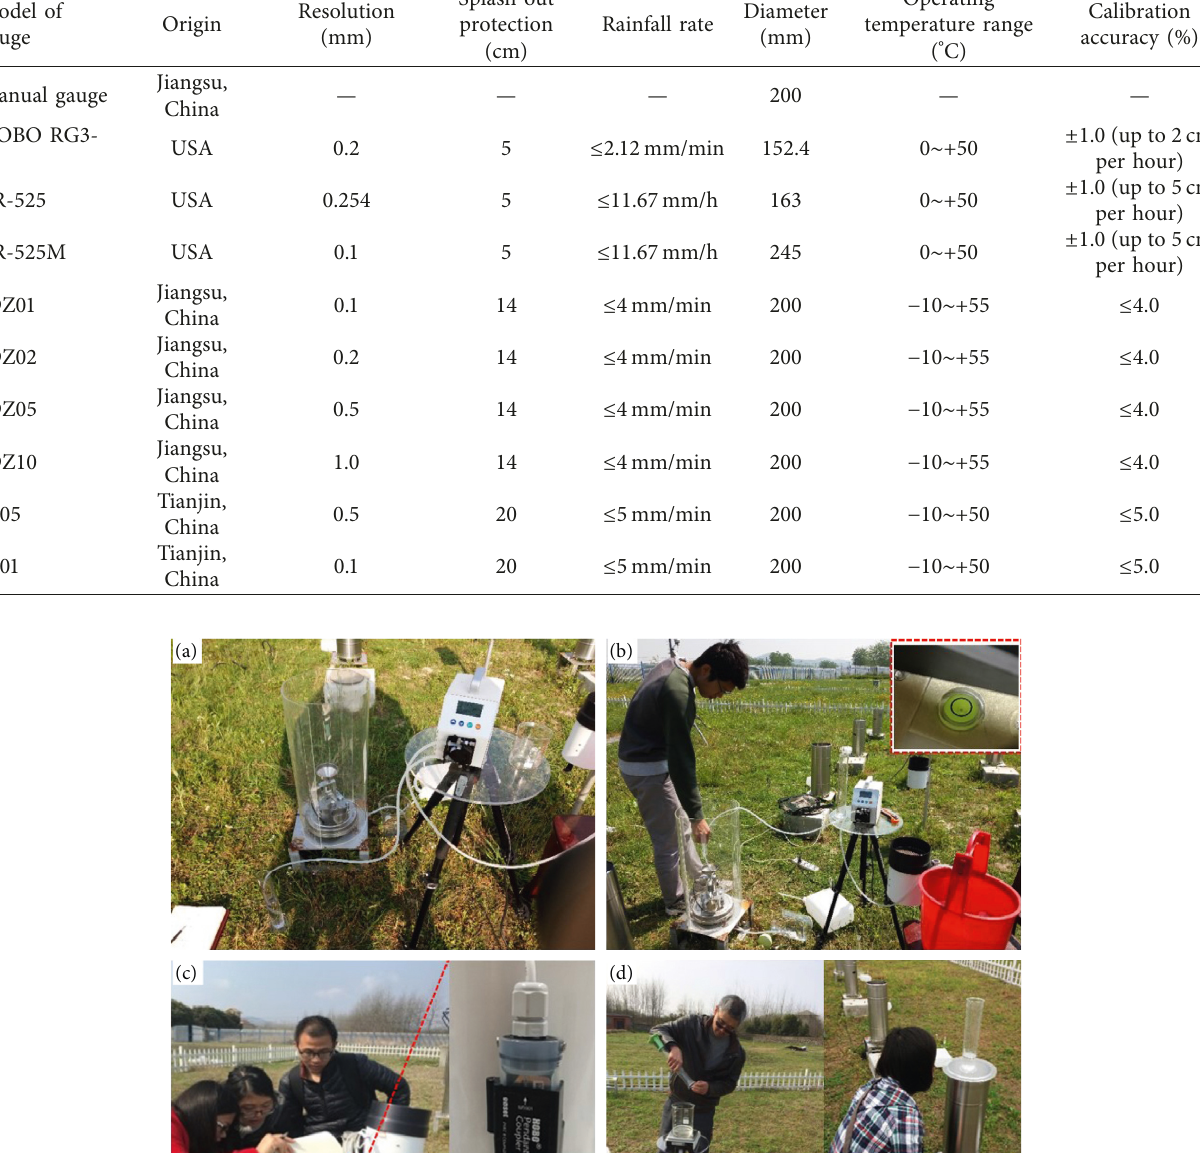
Table 1: Instrumental information at the Chuzhou hydrological experiment station.